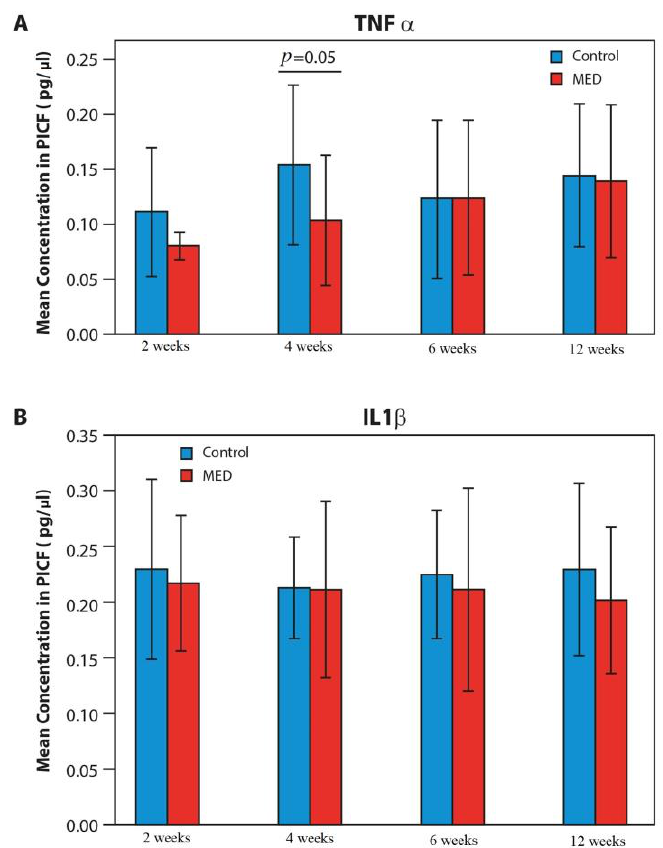
Figure 5. Changes in cytokine levels in the MED and control groups over time, an analysis of variance (ANOVA), and the Tukey post hoc test that followed ANOVA, were used. If homogeneity of variance was significant, the Kruskal–Wallis test was used; results are presented as mean ± SD of the mean. *p < 0.05 control vs. MED.